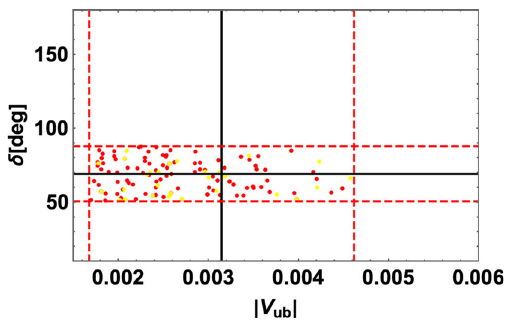
Fig. 2 Allowed value of τ . Yellow and red points present the values within 3 and 5 σ